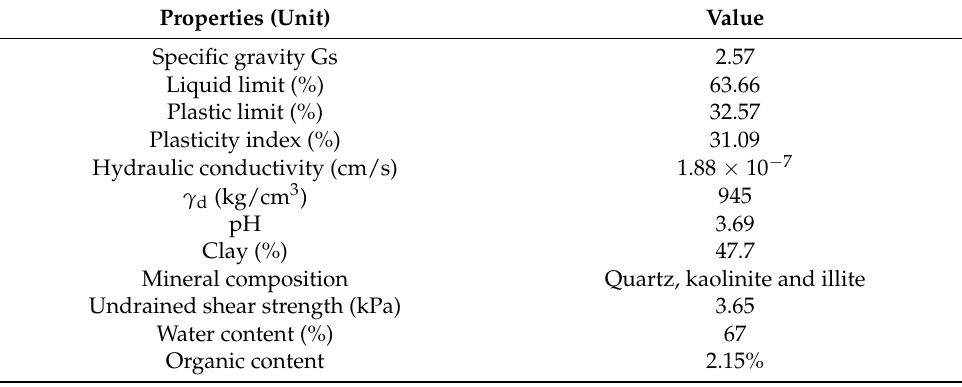
Figure 3. ( a ) Location of Malacca on the Peninsular Malaysia map and ( b ) location of the sampling site for marine clay soil at Malacca River in Malaysia. Table 1. Engineering characteristics of the soil samples.